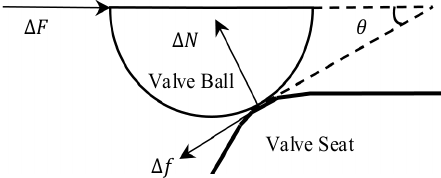
Figure 5. The force of each micro-element.